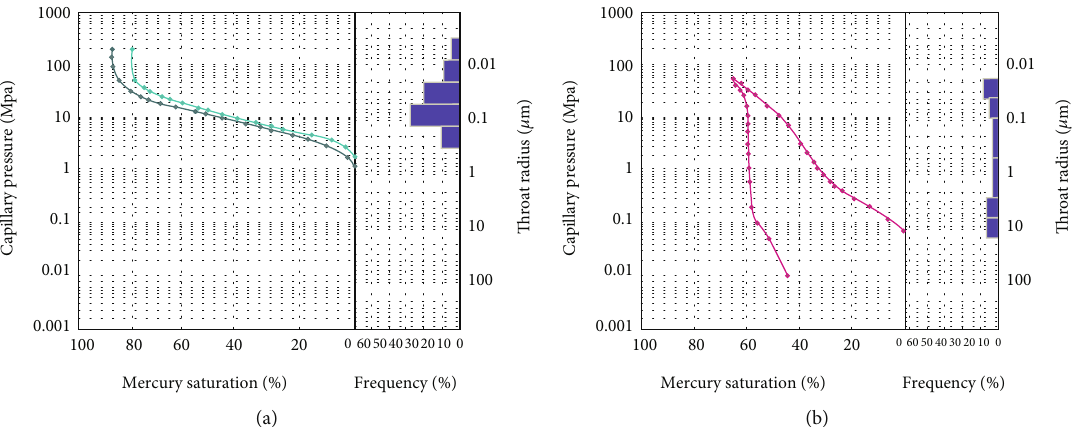
Figure 6: Pore structure of dissolution pore-type dolostone reservoir. ((a) MAFS pore structure, well Y1165, 4089.80m; (b) MECM pore structure, well Y1113,